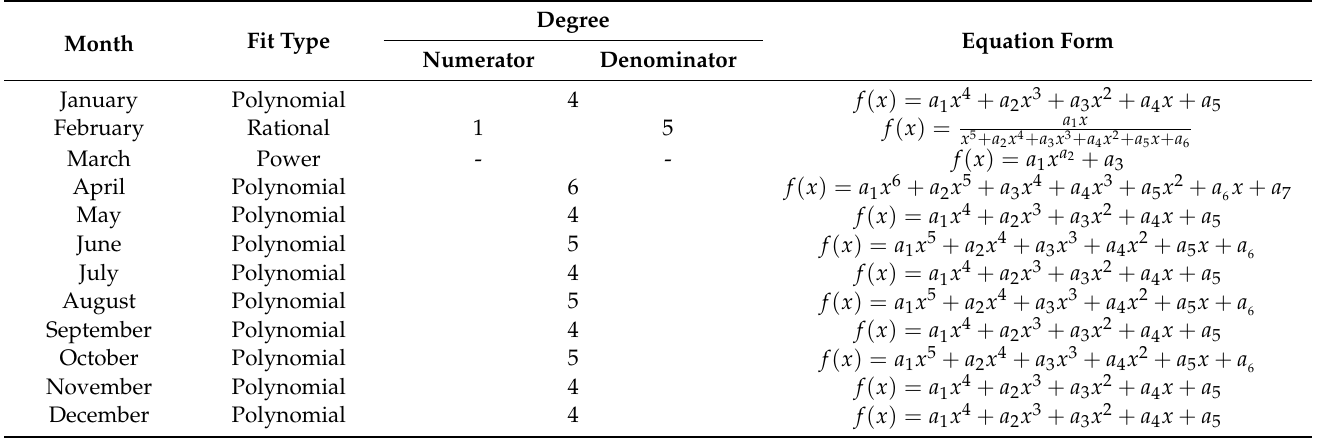
Figure A2. Monthly fitted FDC of Wujiangdu section. Table A3. Fit type and equation form of Wujiangdu section.